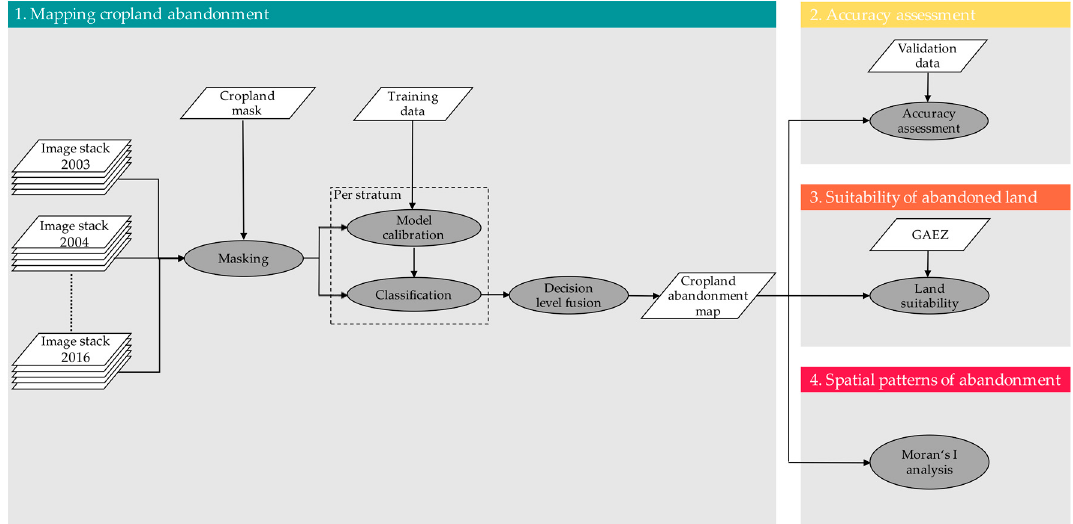
Figure 5. Scheme showing the workflow for mapping abandoned cropland using the stratified classifier (Section 3.1). The skewed rectangles represent input and output data sets, whereas ellipses represent analytical steps.